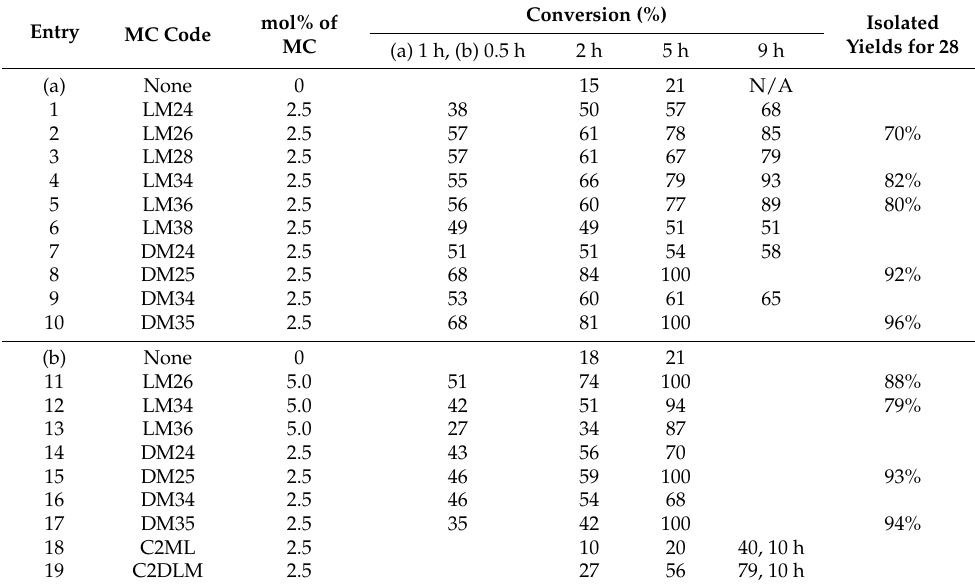
Scheme 5. Cycloaddition reactions of sugar azide with different acetylenes. Table 2. Effect of the macrocycles on catalyzing the click reactions of phenylacetylene. Table 2. Effect of the macrocycles on catalyzing the click reactions of